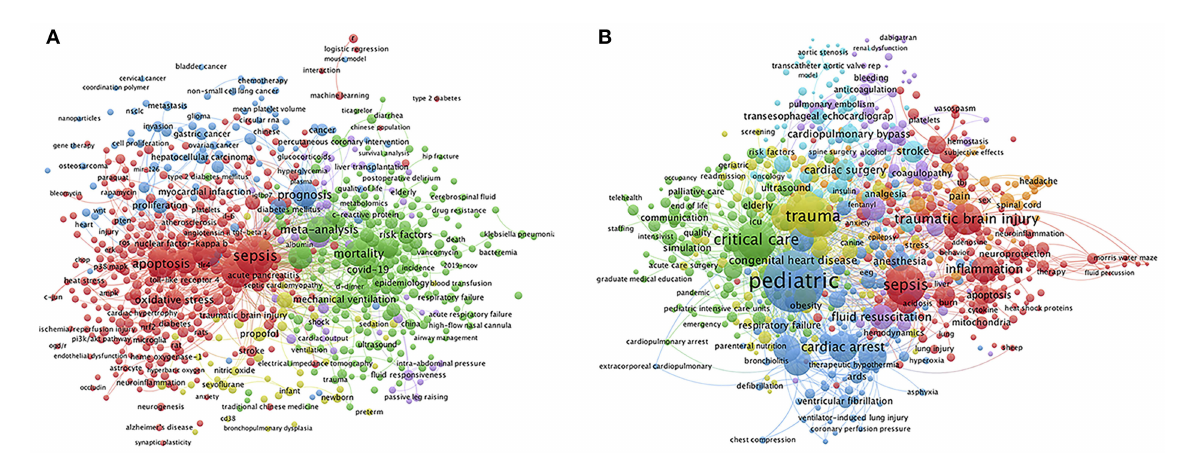
FIGURE2 Visualization map of Keywords co-occurrence network in publications on Critical Care Medicine research. Keywords co-occurrence network in articles published by authors from affiliations of CCM or ICU in Chinese (A) vs American (B) hospitals from 2001 to 2020 were mapped. The size of the circles indicated the co-occurrence frequency of keywords. The color of each circle indicated clusters, which was a set of keywords calculated in the co-occurrence network as a community. The connecting lines indicated co-occurrence of the 2 keywords at both ends. The thickness of lines between circles indicated strength of linkage calculated by the frequency of